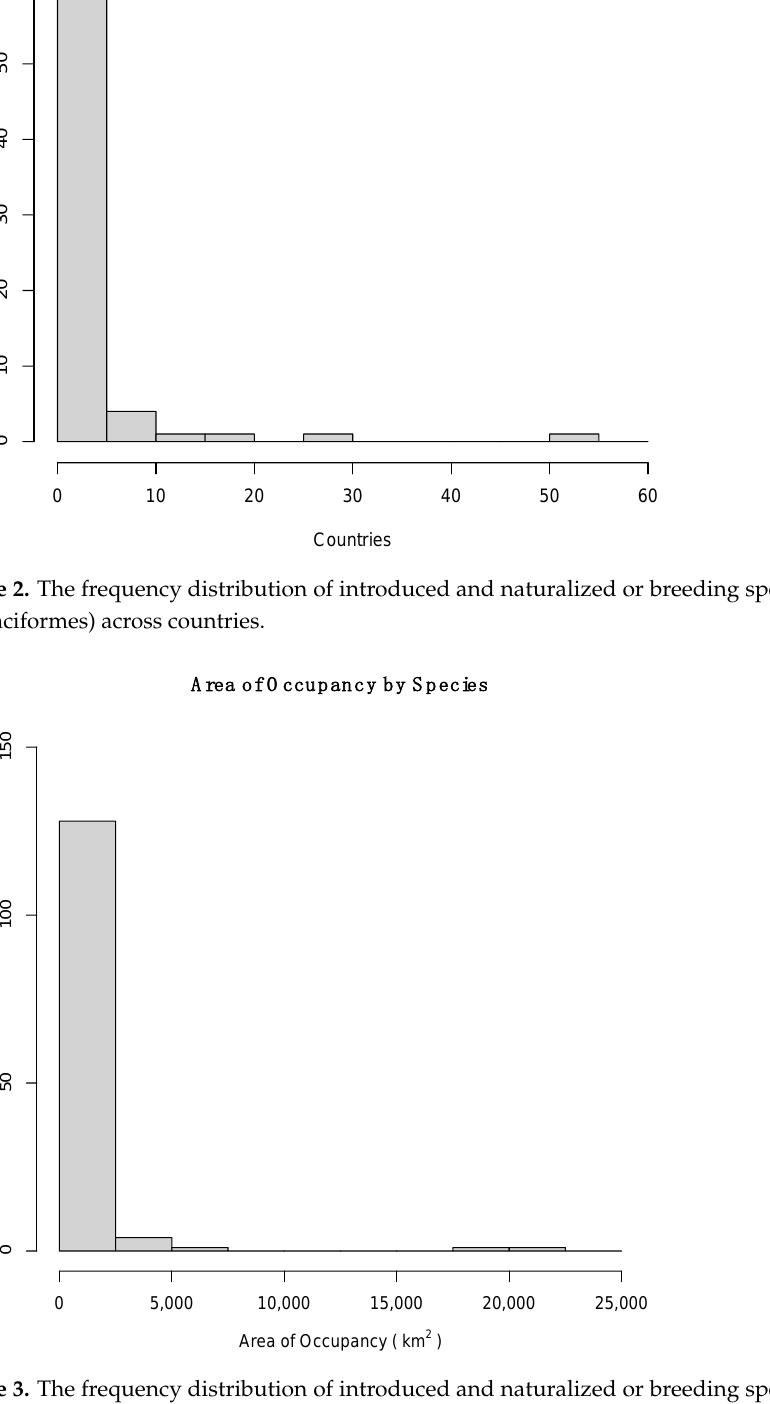
cies, Taiwan (9 species), and Singapore (8 species). This order is different if we consider records for all introduced species combined. That list is: United States (87 species), Brazil and Spain with 52 species, Australia and Puerto Rico with 35 species, and Mexico (20 spe- cies) (Table S1). Figure 4. Relationship between area of occupancy and the number of countries that introduced par- rots have been seen in the wild or are naturalized or breeding.